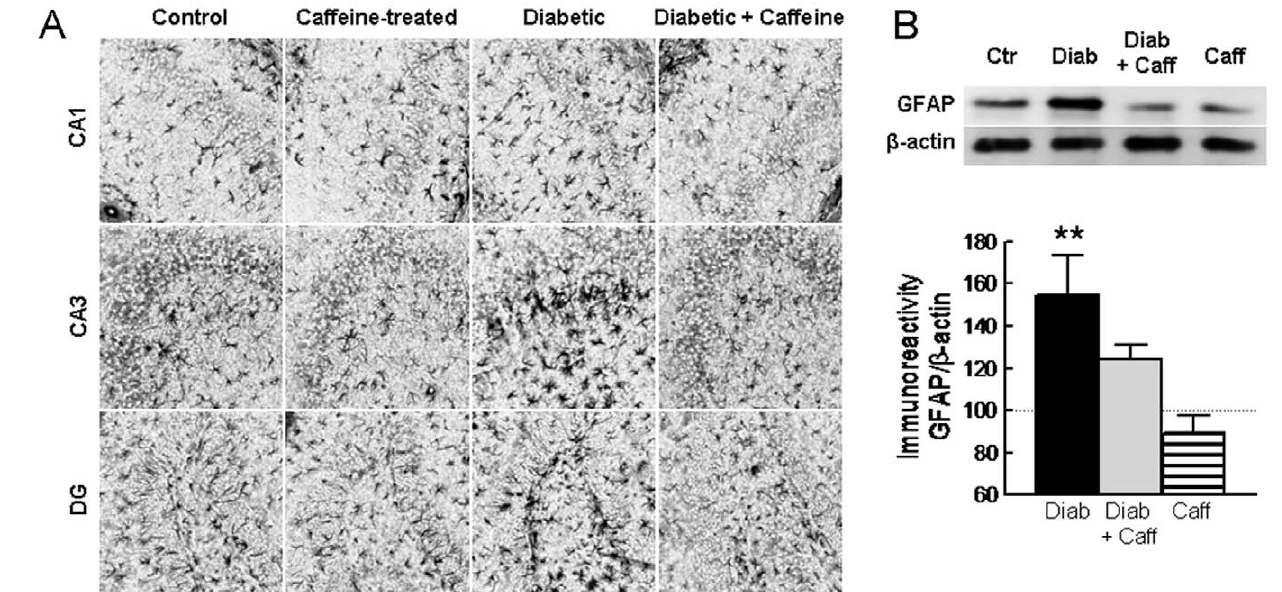
Figure 5 . Caffeine preventes astrocytosis caused by diabetes . Panel A shows representative GFAP immunoreactivity photographs of CA1, CA3 and dentate gyrus (DG) showing that diabetic mice displayed increased number of GFAP-positive cells in the hippocampus, but not when consuming caffeine. This was quantitatively confirmed by Western blot (B). GFAP immunoreactivity was normalised to b -actin in the same membrane and calculated as percentage of control. Black, grey and striped bars represent diabetes (Diab), diabetes plus caffeine and caffeine (Caff) groups, respectively. Data in panels (A) and (B) are representative of 4–5 animals per group and in panel (C) the data are mean 6 SEM of n=5–6 mice in each experimental group. **P , 0.01 versus control.